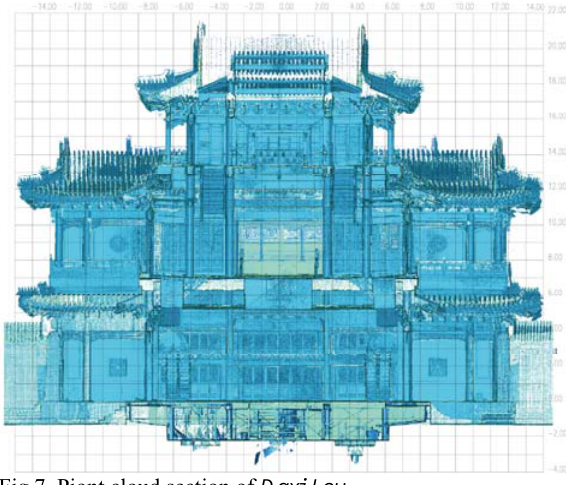
Fig.7. Piont cloud section of Daxi Lou